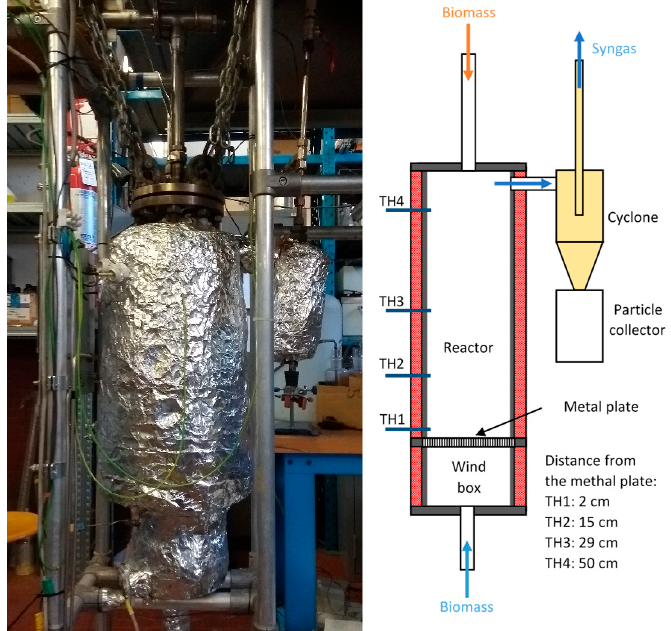
Figure 1. A gasification reactor installed at the Department of Mechanical and Aerospace Engineering Laboratory, Sapienza University of Rome ( left ). Detailed scheme of the reactor interior ( right ).